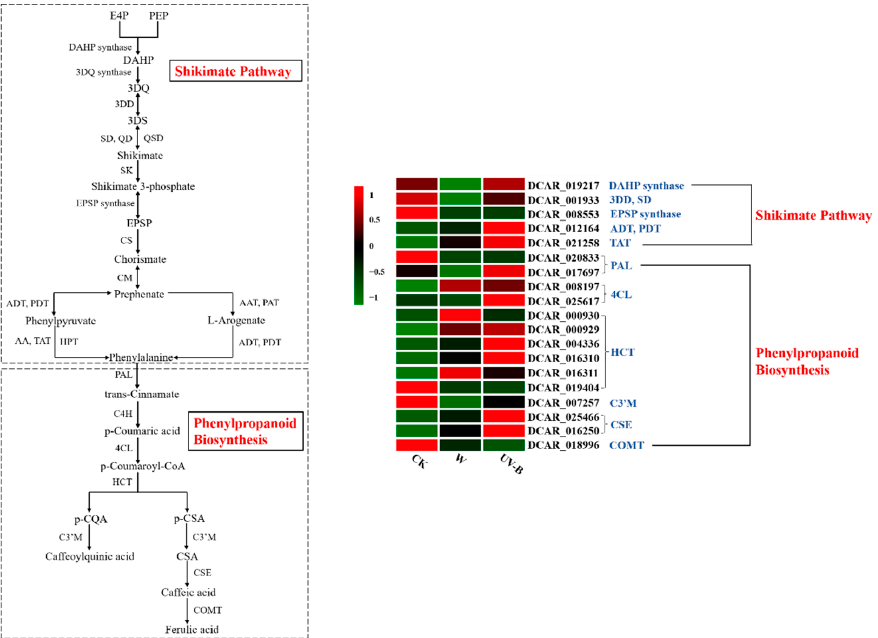
Figure 5. Metabolic pathways of the shikimate pathway and phenylpropanoid biosynthesis. Heat map of expression profiles of DEGs associated with penylpropanoid biosynthesis in different samples after storage at 15 °C for 1 h. The DEGs were screened from two metabolic processes of the shikimate pathway and phenylpropanoid biosynthesis. Each column represents a treatment (CK, W and UV-B), and each row represents a screened DEG. The color scale indicates the expression value of each DEG: red color means high expression, and green color means low expression. E4P, D-erythrose 4-phosphate; PEP, phosphoenolpyruvate; DAHP, 2-dehydro-3-deoxy-D-arabino-heptolosonate-7-phosphate; 3DQ, 3-dehydroquinate; 3DD, 3-dehydroquinate dehydratase; 3DS, 3-dehydro-shikimate; SD, shikimate dehydrogenase; QD, quinate dehydrogenase; QSD, quinate/shikimate dehydrogenase; SK, shikimate kinase; EPSP, 5-enolpyruvylshikimate 3-phosphate; CS, chorismate synthase; CM, chorismate mutase; ADT, PDT, arogenate dehydratase/prephenate dehydratase; AAT, PAT, bifunctional aspartate aminotransferase and glutamate/aspartate-prephenate amino transferase; AA, aspartate aminotransferase; TAT, tyrosine aminotransferase; HPT, histidinol-phosphate aminotransferase; PAL, phenylalanine ammonium lyase; C4H, cinnamate-4-hydroxylase; 4CL, 4-coumarate coenzyme A ligase; HCT, shikimate O-hydroxycinnamoyltransferase; p-CQA, p-coumaroylquinic acid; p-CSA, p-coumaroylshikimic acid; C3 (cid:48) M, coumaroylquinate (coumaroylshikimate) 3’-monooxygenase; CQAs, caffeoylquinic acids; CSA, coumaroylshikimic acid; CSE, caffeoylshikimate esterase; COMT, caffeate O-methyl